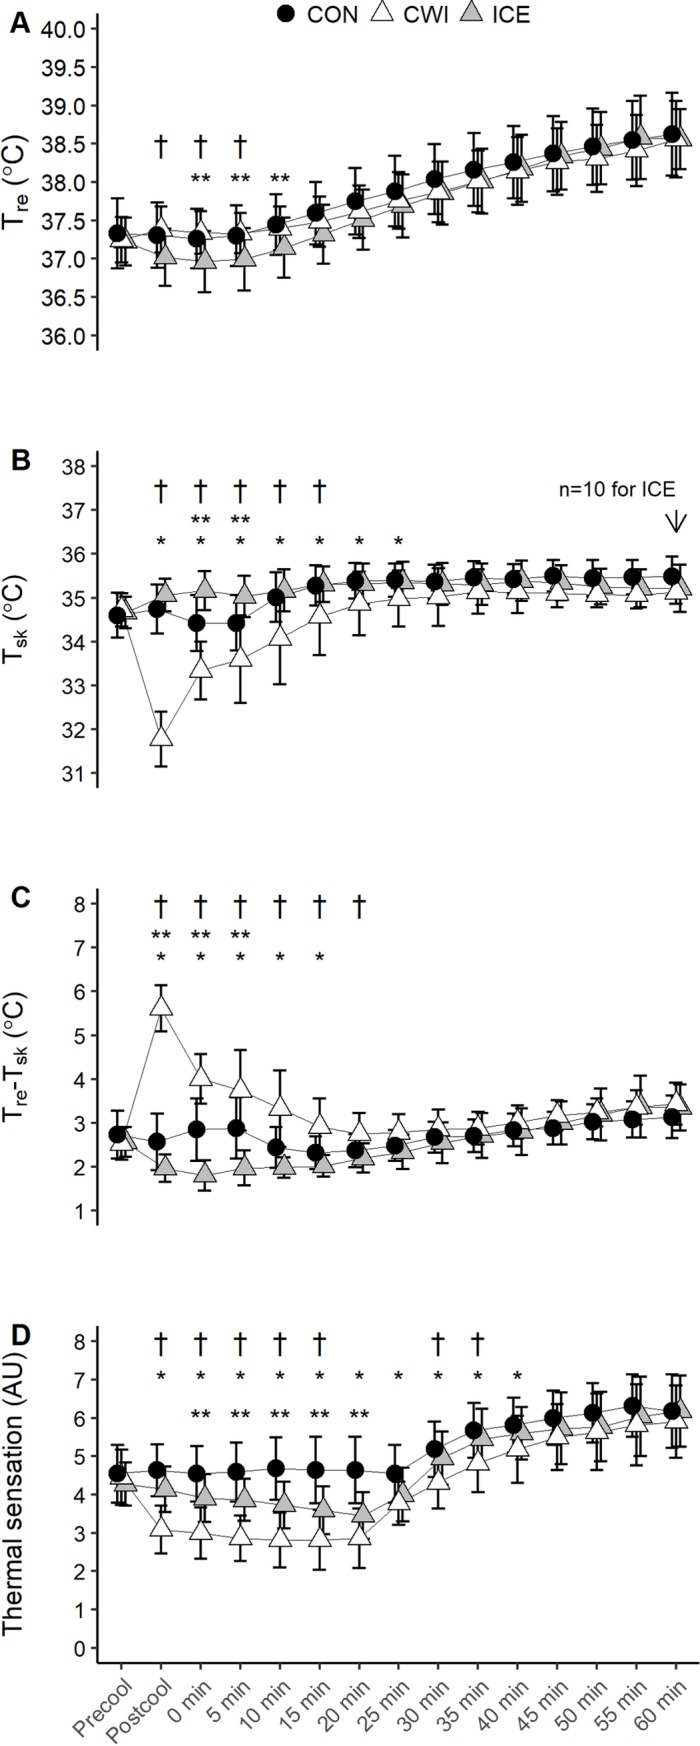
Tre (A), Tsk (B), and
Tre-Tsk gradient (C), and thermal
sensation (D) during 60 min of cycling at RPE 15 (study
2). CON, control; CWI, cold -water immersion; ICE, ice
slushy ingestion; * p<0.05 CWI versus CON; ** p<0.05 ICE
versus CON; † p<0.05 CWI versus ICE. Data are mean ± SD for
n = 11 unless otherwise stated. Due to missing
data at certain time points during the exercise, data for
Tre and Tre-Tsk gradient are
n = 11 during the first 25 min of exercise for
all conditions, and n = 10 for CWI and ICE
thereafter (see S3 and S4 Tables for clarification).